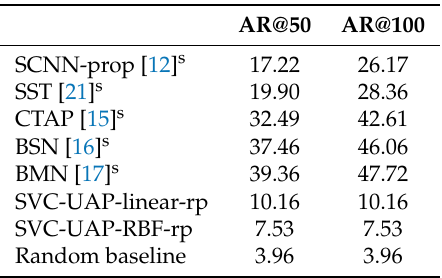
Figure 8. Performance in terms of AR-AN for the problem of Action Proposals in Thumos’14 dataset. Comparison ofthe proposed approach with different kernels for the SVC module, including the random baseline. Table 5. Comparison with the state-of-the-art for the problem of AP in Thumos’14. s indicates the method is